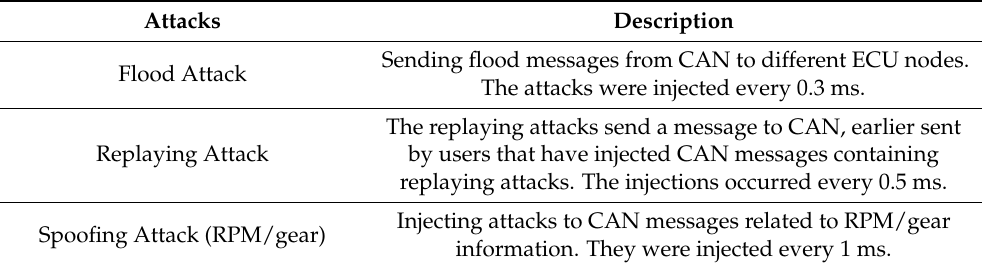
Table 1. CAN bus attacks.